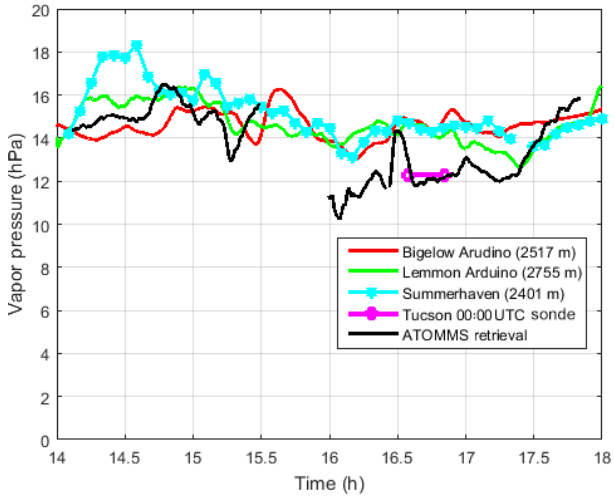
Figure 7. Observed and retrieved vapor pressures. The sonde line indicates the average vapor pressure over the altitude range of the ATOMMS instruments as reported in the 00:00 UTC Tucson sonde for 19